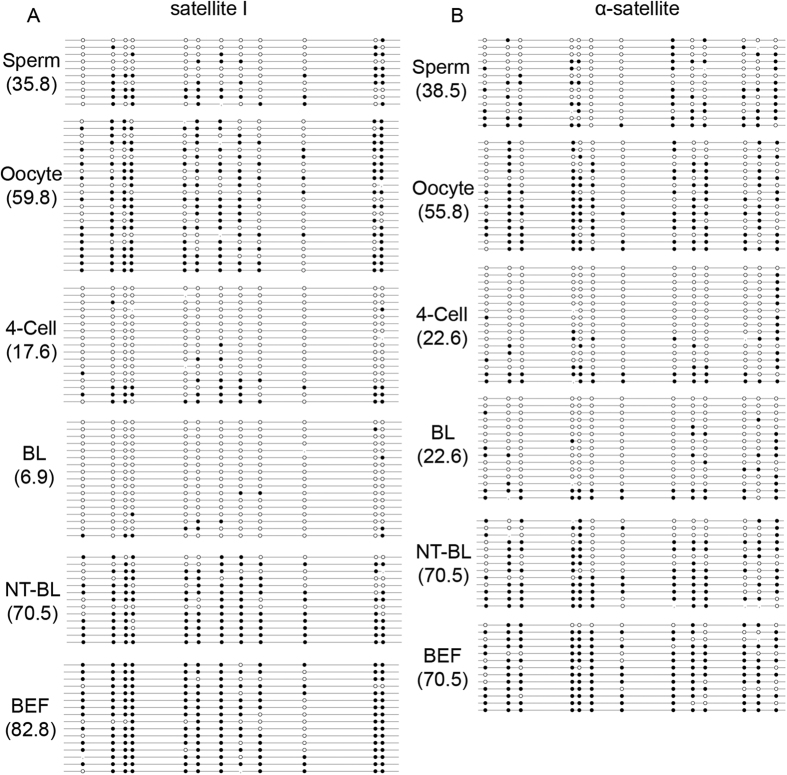
Dynamic DNA methylation profiles of satellite I and α-satellite in bovine gametes, IVF preimplantation embryos, SCNT blastocysts and BEFs.(A) Satellite I showed hypermethylation in gametes. After fertilization, the zygotic genome lost DNA methylation in 4-cell embryos, and the DNA methylation levels further decreased in blastocysts. However, BEFs and SCNT blastocysts maintained a high level of satellite I methylation. (B) α-satellite showed slight DNA demethylation from gametes to IVF blastocysts and hypermethylation in BEFs and SCNT blastocysts. The filled (black) circles correspond to methylated cytosines, the unfilled (white) circles indicate unmethylated cytosines and the small vertical lines without a circle correspond to missing values. The number denotes the percentage of methylated cytosines observed at all of the CpG sites. BL: IVF blastocysts; NT-BL: SCNT blastocysts; and BEFs: bovine embryonic fibroblasts.